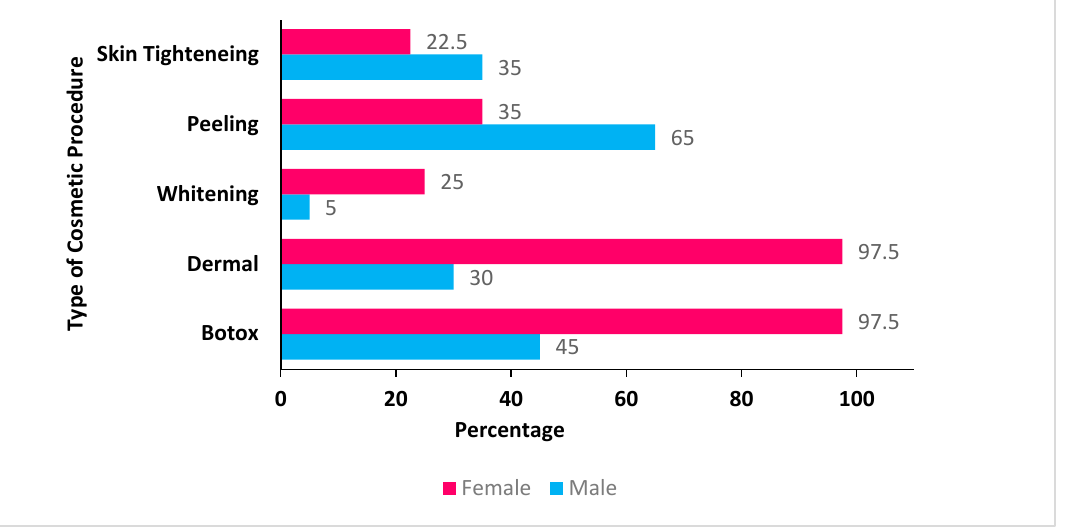
Figure 6. Participants’ desired cosmetic procedures when offered free of